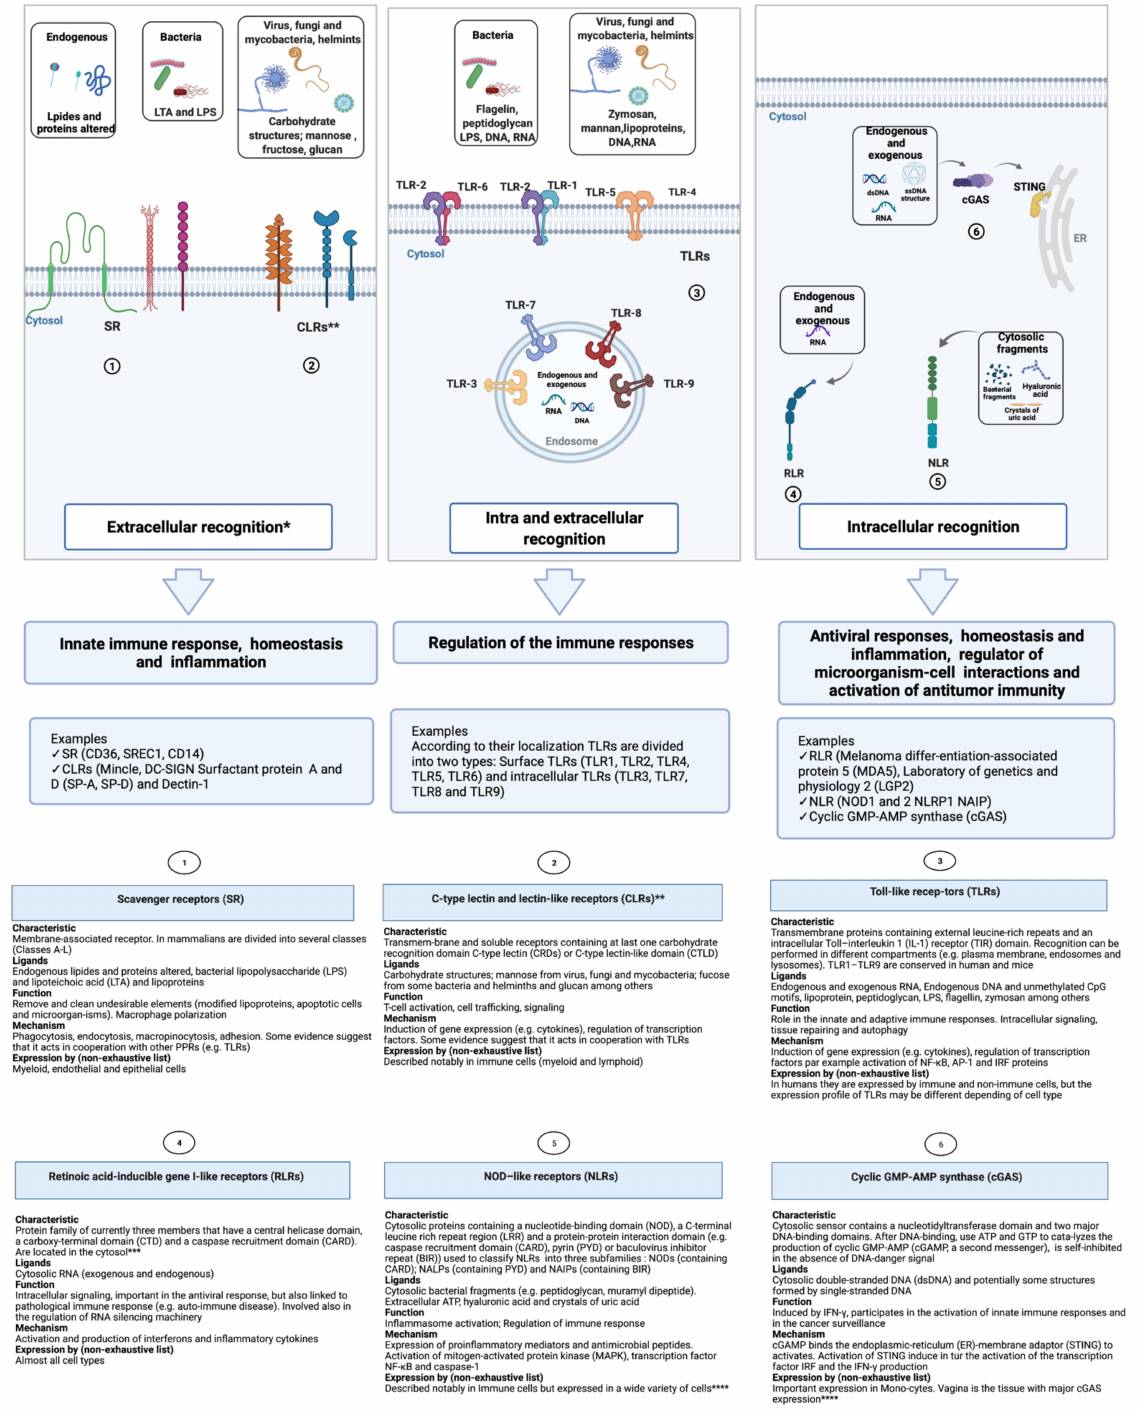
Figure 2. Molecular patters and receptors impacting innate immune response, homeostasis, and inflammation. * Despite